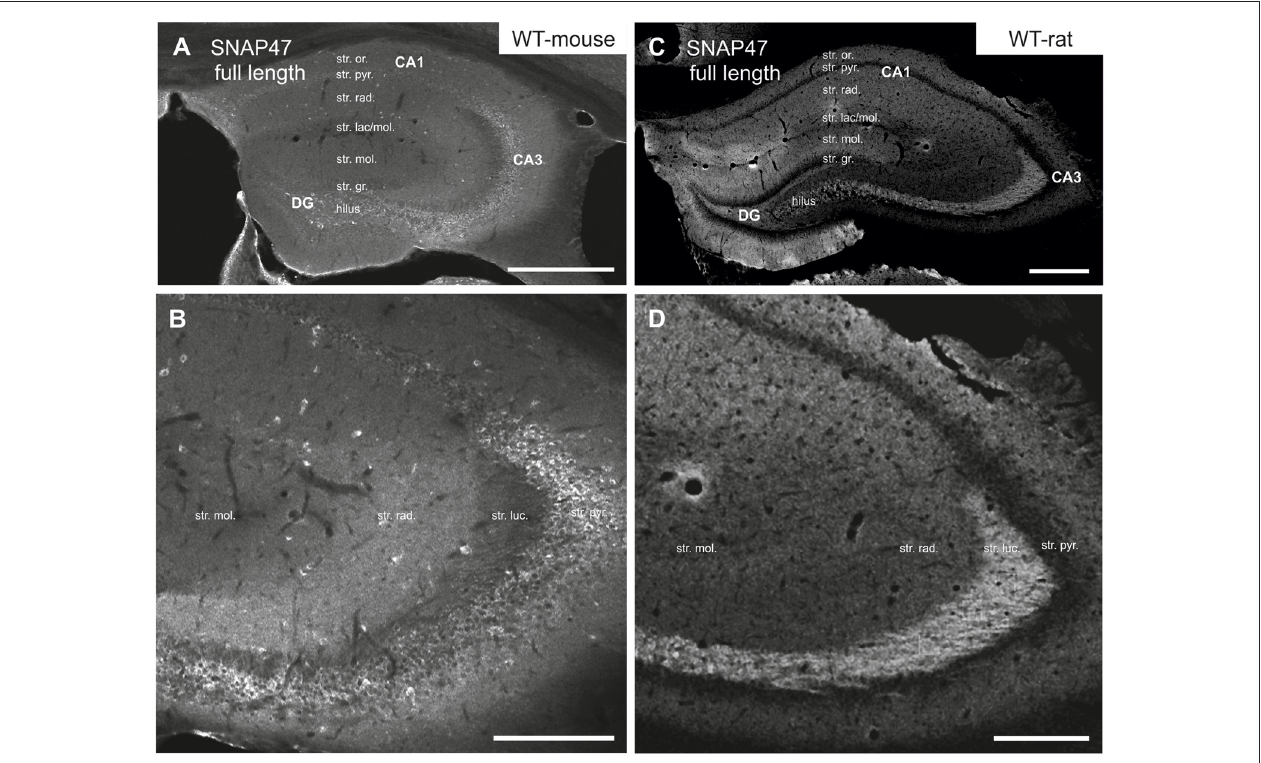
FIGURE 2 | Immunofluorescence labeling pattern of SNAP47 in the hippocampus of WT mice and rats. (A,B) Confocal images of SNAP47 immunolabeling in the mouse hippocampus. Note the highly labeled neurons scattered across all areas and layers of the hippocampus. The intensity of SNAP47 is stronger in the cell body layer and stratum radiatum of the CA3, contrary to the CA1 area. The lowest immunolabeling of SNAP47 is observed in the CA3 stratum lucidum . (C,D) Confocal images of SNAP47 immunolabeling in rat hippocampus. Note that in the rat section the scattered neurons are not labeled and the labeling intensity is low in the cell body layers. The high intensity of SNAP47 labeling is observed in the stratum lucidum of the CA3 and the stratum radiatum of CA1 area. Scale bars represent, (A–C) , 500 µ m; (B) , 200 µ m; (D) , 275 µ m.